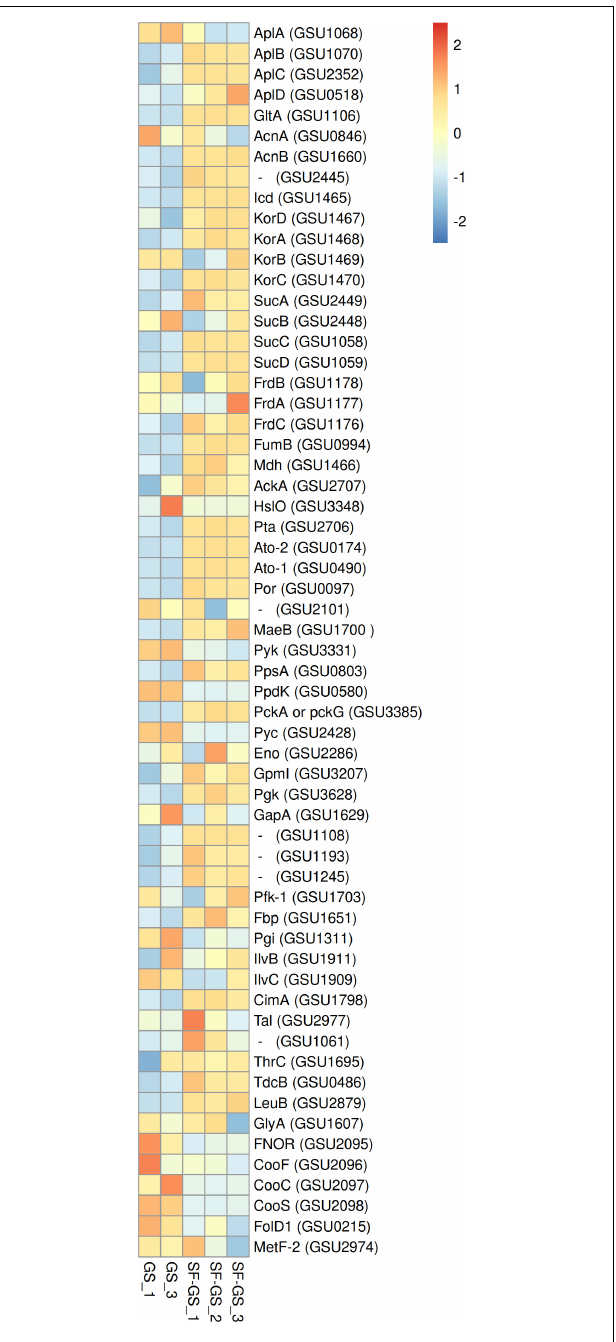
FIGURE 5 | Relative abundance of the detected proteins in the central metabolic network of GS in the SF-GS coculture versus the GS pure culture. Protein abundance levels are shown after Z -score normalization. The color intensity indicates the degree of protein presence, where high relative abundance is indicated in red and low relative abundance is indicated in blue. The rows in the heat map show the detected proteins in the SF-GS coculture and the GS pure culture. The columns show the cultures in replicates. The abbreviations of the proteins are as follows: sodium/solute symporter family protein (AplA, AplB, AplC, and AplD), citrate synthase (GltA), aconitate hydratase 1 (AcnA), aconitate hydratase 2 (AcnB), aconitate hydratase,